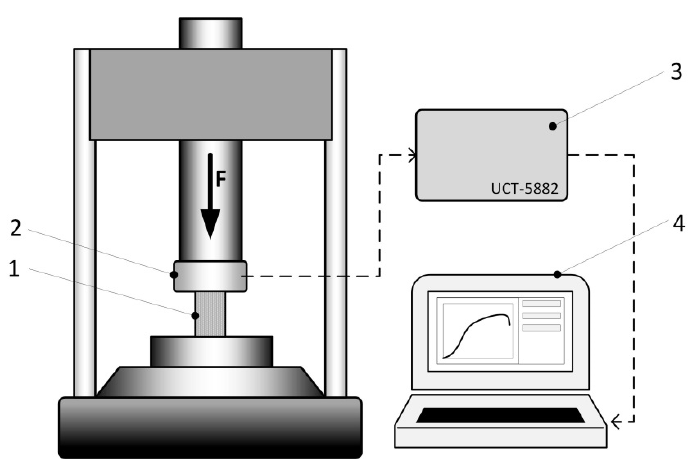
Figure 1. Mechanical test stand (1—sample, 2—hydraulic press, 3, 4—data acquisition and processing system).